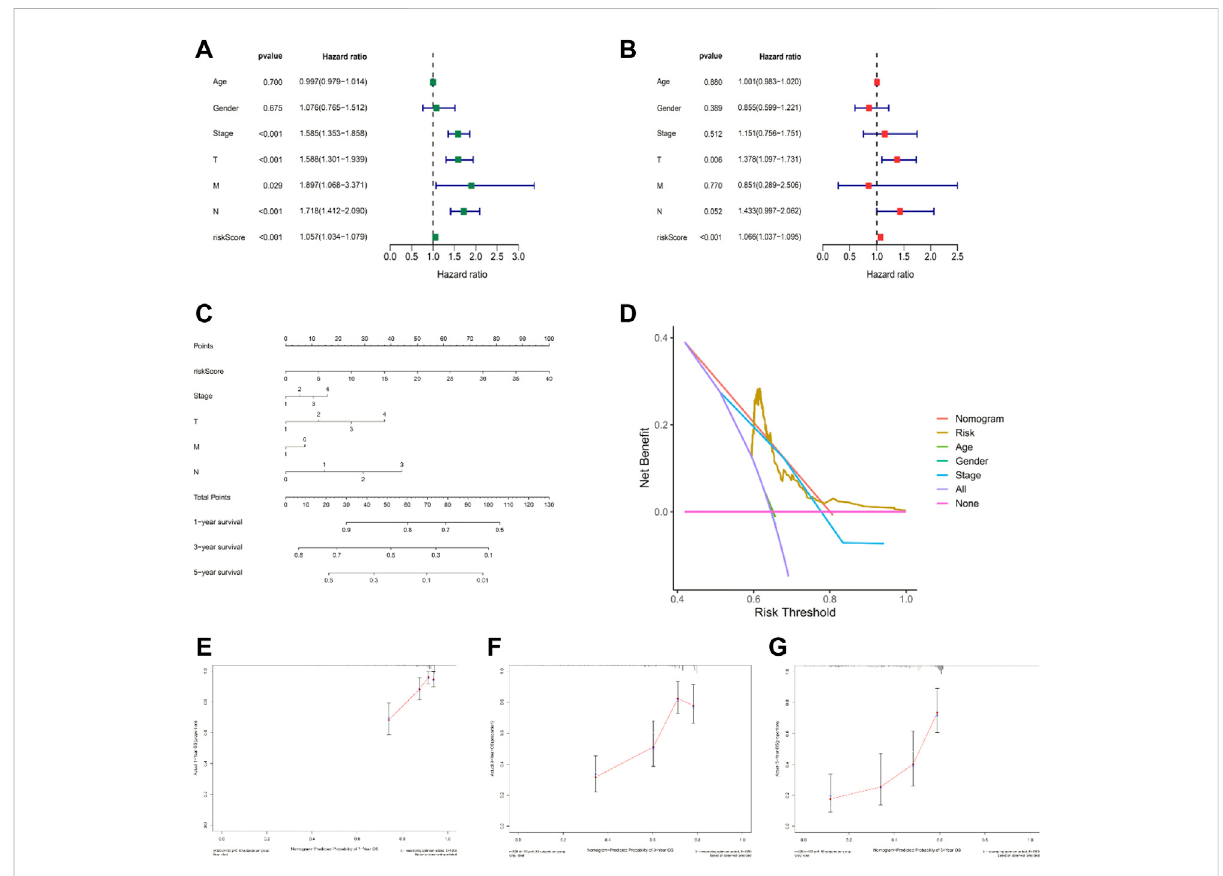
FIGURE 5 Nomogramandindependentprognosticfactoranalysis. (A,B) Resultofunivariate/multivariateCoxregressionanalyses. (C) Nomogrampredicts the probability of the 1-, 3-, and 5-years OS. (D) Result of DCA. (E – G) 1-, 3-, and 5-years predicted